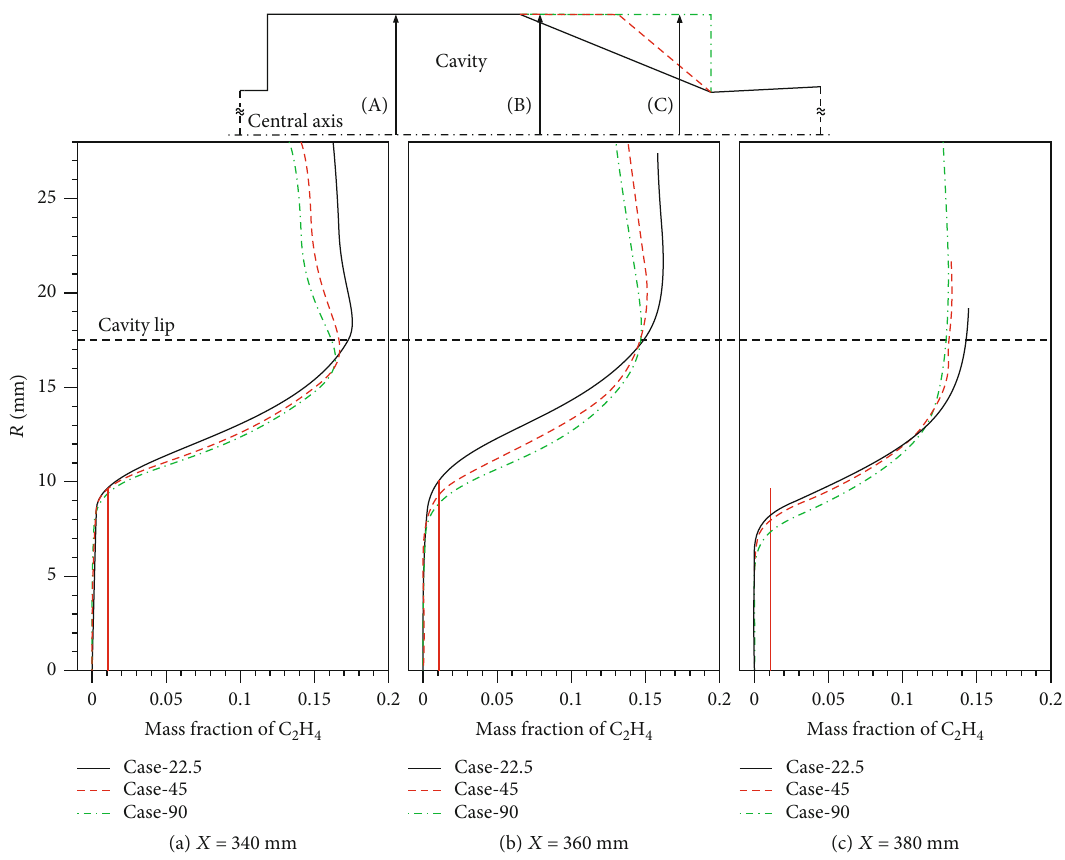
Figure 10: Mass fraction of C where the mass fraction of C